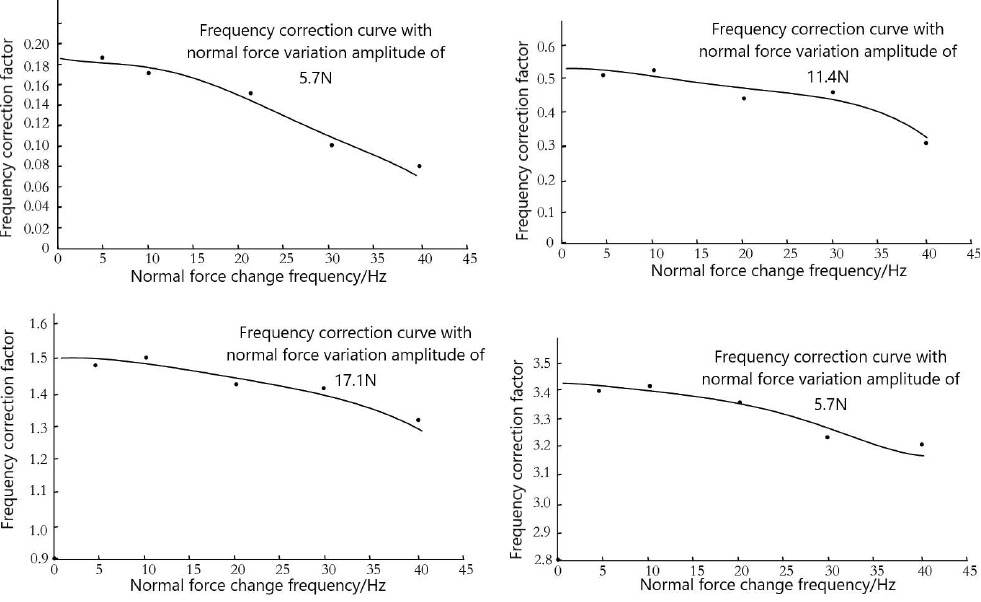
Figure 8. Curves of frequency correction coefficient under different impact.